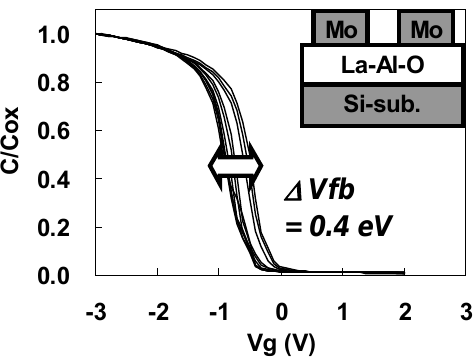
Figure 33. C-V curves for Mo/La-Al-O/Si gate stack capacitors along the wafer diameter over which the composition was changed.